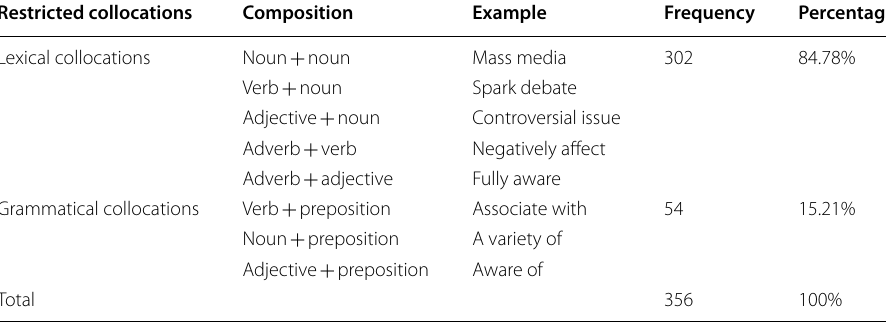
Table 6 Restricted collocations used in IELTS writing task 2 Restricted